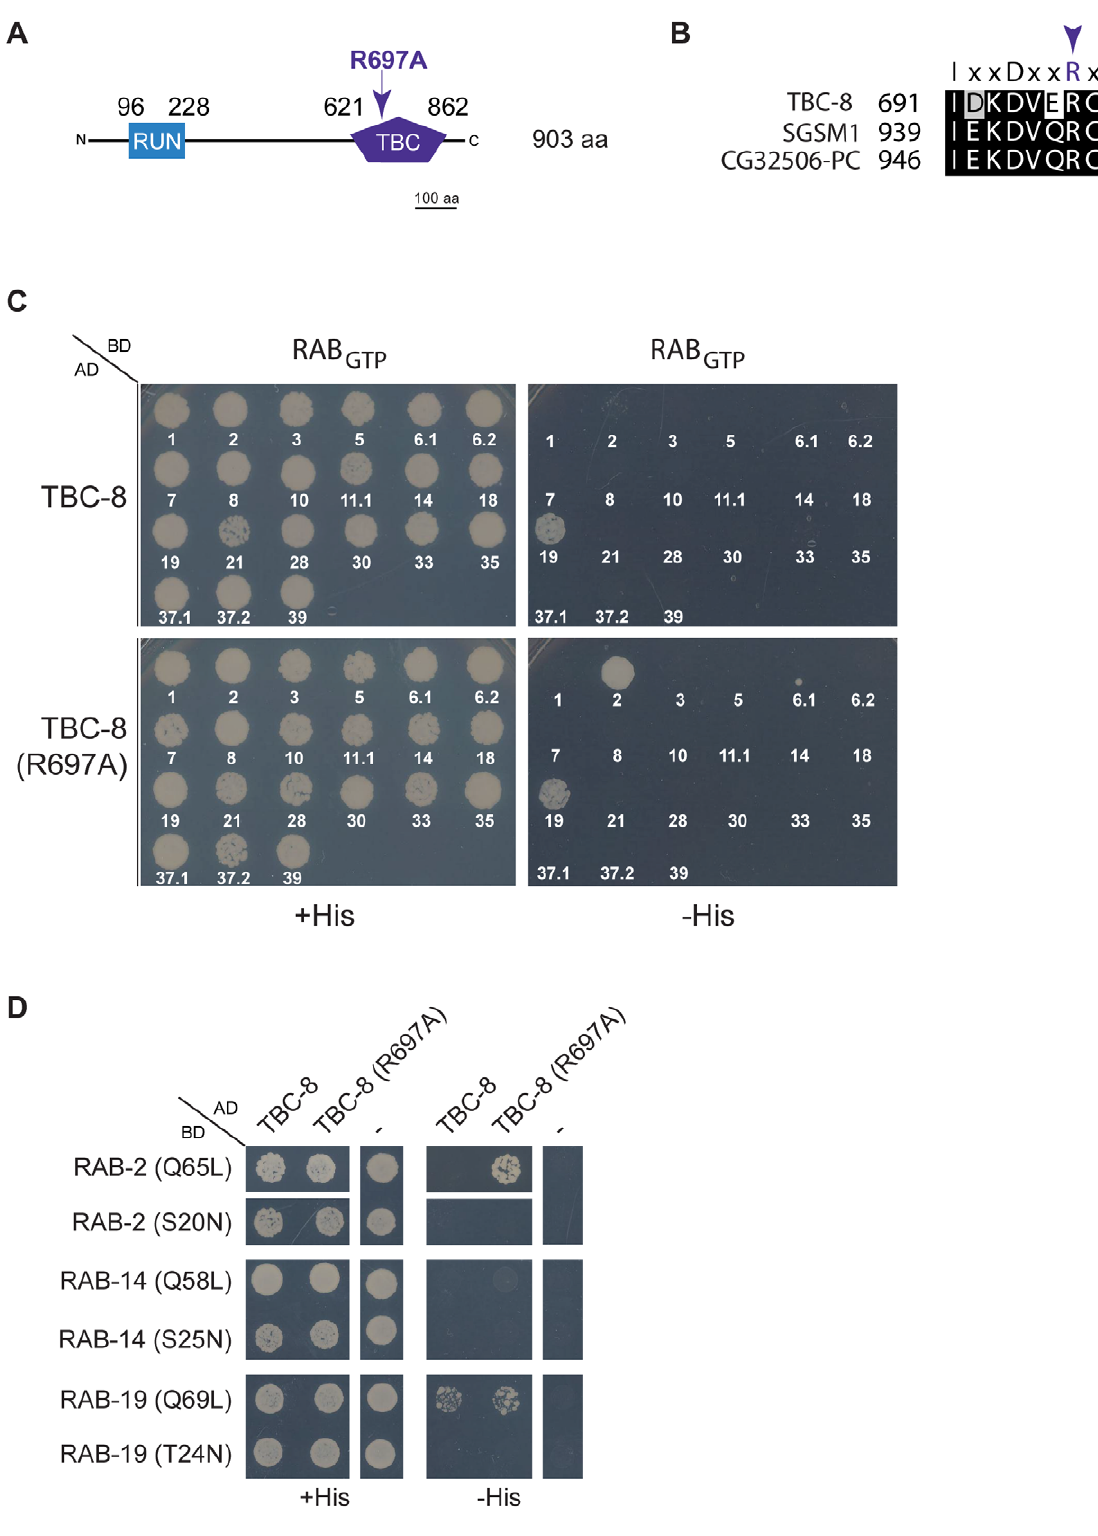
Figure 6. TBC-8 is a putative RAB-2 GAP. (A) TBC-8 contains two predicted domains: an N-terminal RUN domain (96 to 230 aa) (blue) and a C- terminal TBC-domain (621 to 862 aa) (purple). Mutation of the catalytically active arginine (R697) to alanine within the TBC-domain is indicated. Please see Figure S4 for full protein sequence. (B) Alignment of the catalytic motif of TBC-8 and its orthologs in humans (SGSM1) and in Drosophila melanogaster (CG32506-PC) are shown. The arrow indicates the catalytic arginine residue necessary for GAP activity. (C) In a yeast two-hybrid assay, all C. elegans Rabs in their constitutively GTP-bound form were tested against wild type TBC-8 (upper panel) and a catalytically inactive form of TBC-8 (R697A) (lower panel), respectively. Strikingly, RAB-2 (Q65L) interacted with TBC-8 (R697A) but not with wild type TBC-8, suggesting that TBC-8 is the GAP for RAB-2. Unlike RAB-2, RAB-19 (Q69L) interacted weakly with both forms of TBC-8. (D) Interactions of RAB-2 and RAB-19 with TBC-8 occurred in